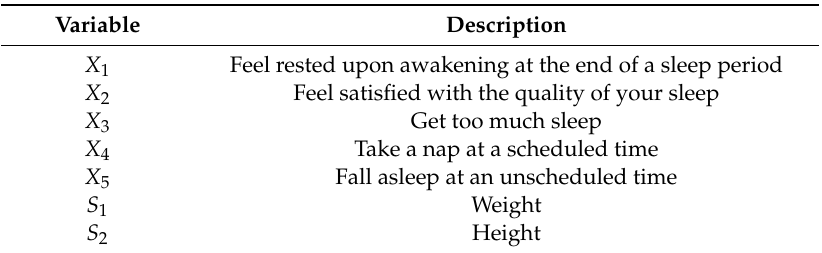
Table 3. Questions.